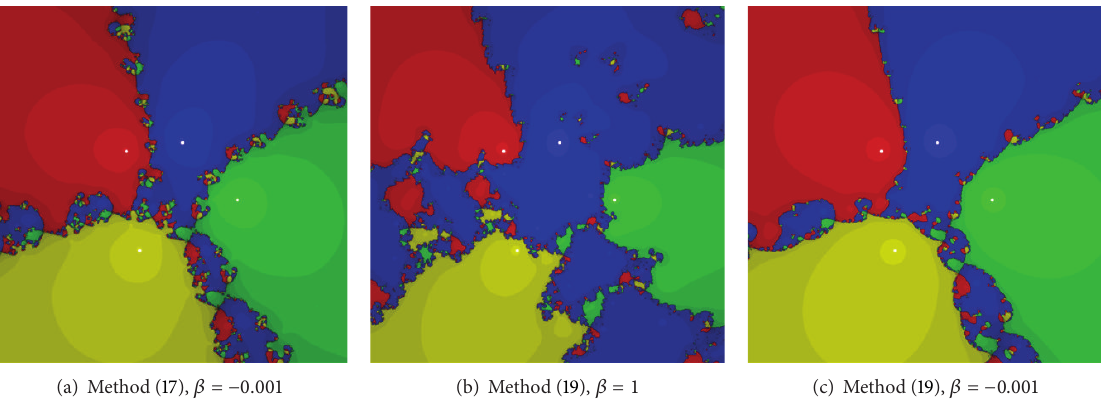
Figure 24: Basins of attraction for the test problem 4.